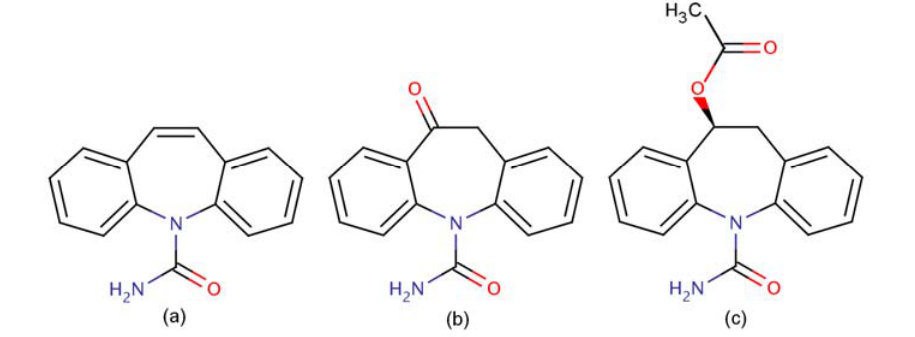
Figure 1. The chemical structures of three different dibenzazepines: (a) carbamazepine (CBZ); (b) oxcarbazepine (OXC) and (c) eslicarbazepine acetate